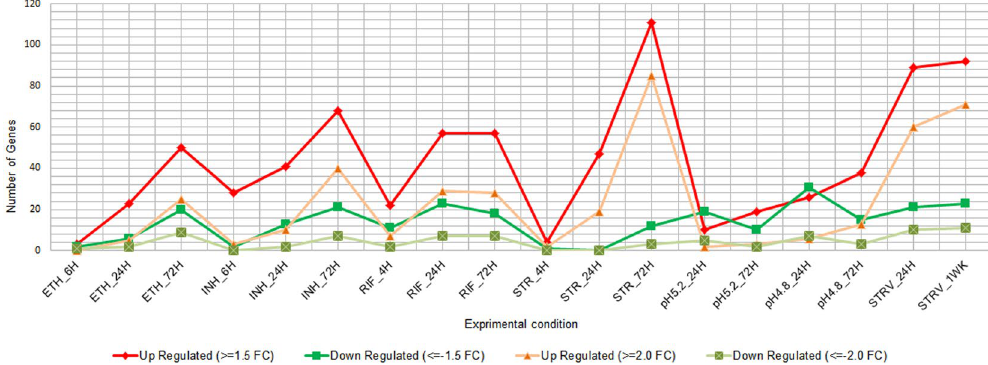
Figure 2. Differentially expressed TA Loci across experimental conditions. Line Graph depicts the number of TA genes that are upregulated and downregulated in each experimental condition at 1.5 and 2.0 fold change. Total number of up and down regulated toxin and antitoxin genes for each condition were plotted using Microsoft excel. The Y-axis indicates total number of toxin and antitoxin genes differentially regulated and X-axis indicates the experimental conditions and time points of the study. Ethambutol (ETH), Isoniazid (INH), Rifampicin (RIF), Streptomycin (STR), Starvation (STRV). 4 H, 6 H, 24 H, 72 H denotes the duration of treatment as 4 hours, 6 hours, 24 hours and 72 hours. 1WK denotes treatment for 1 week.